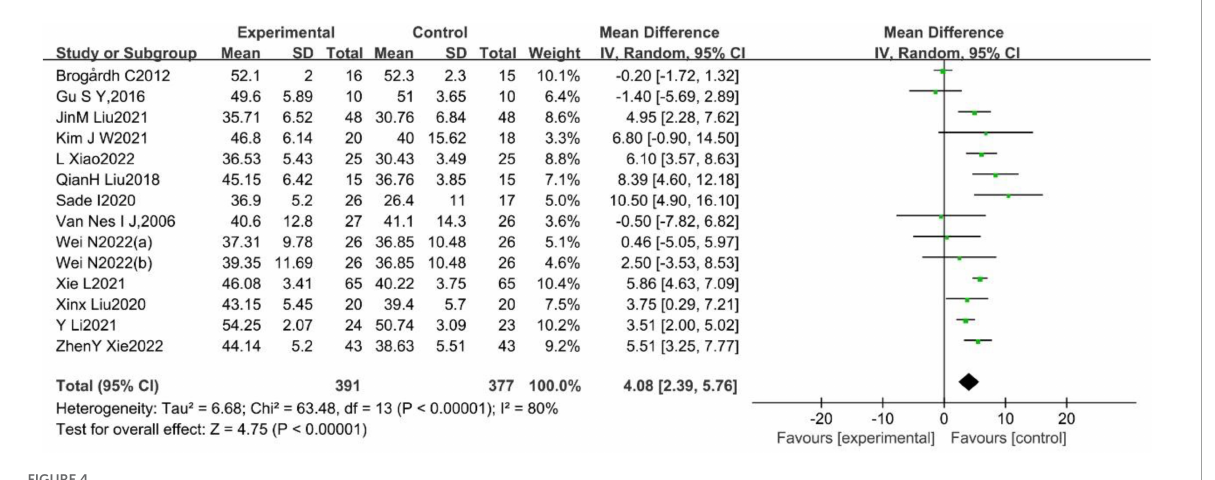
FIGURE4 Forest plot of the effects of WBV training on